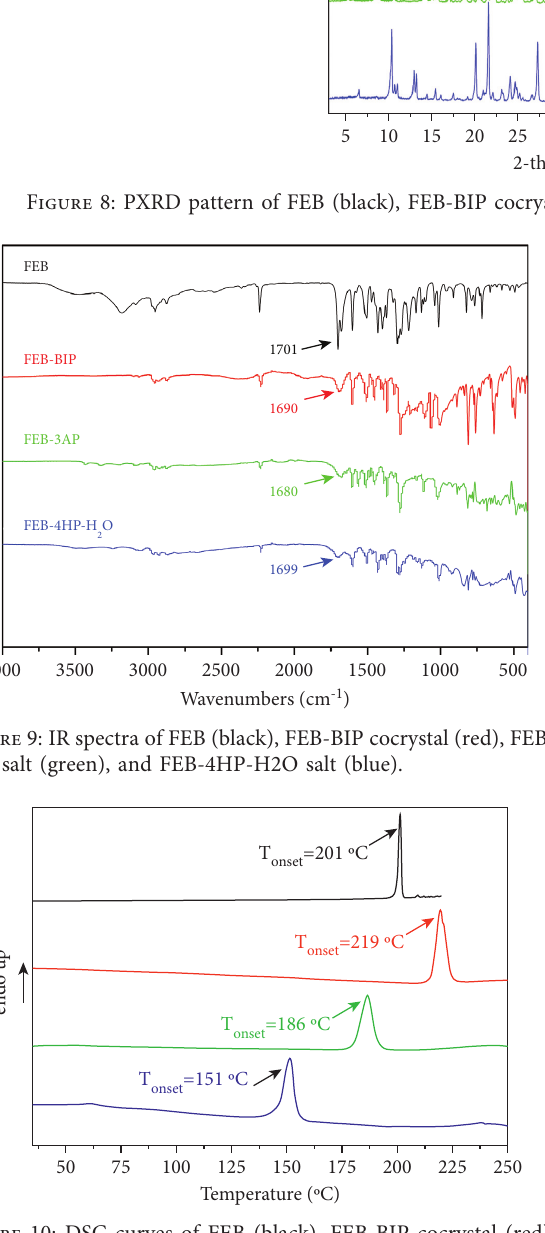
Figure 10: DSC curves of FEB (black), FEB-BIP cocrystal (red), FEB-3AP salt (green), and FEB-4HP-H2O salt (blue) recorded at 10 ° C /min heating rate.